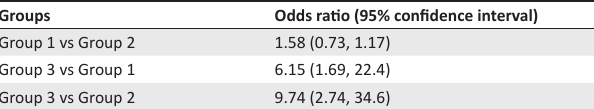
TABLE 2: Effectiveness of recruitment strategies.